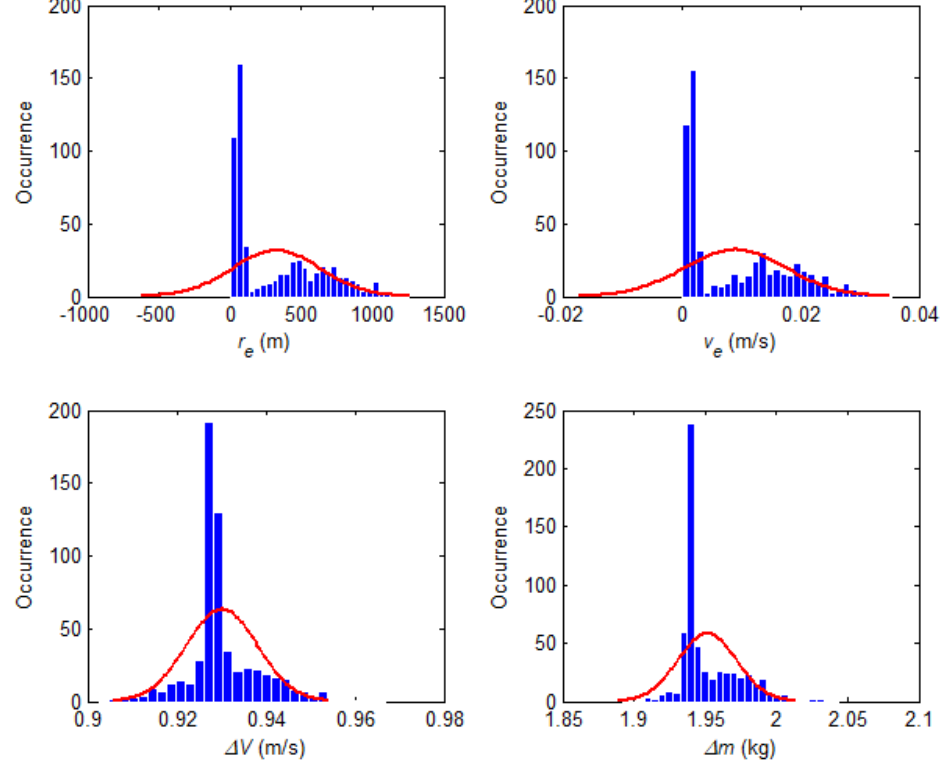
Figure 11. Occurrence of the Monte Carlo simulation (Error setting III, ε = 2 TOF 40 h ).